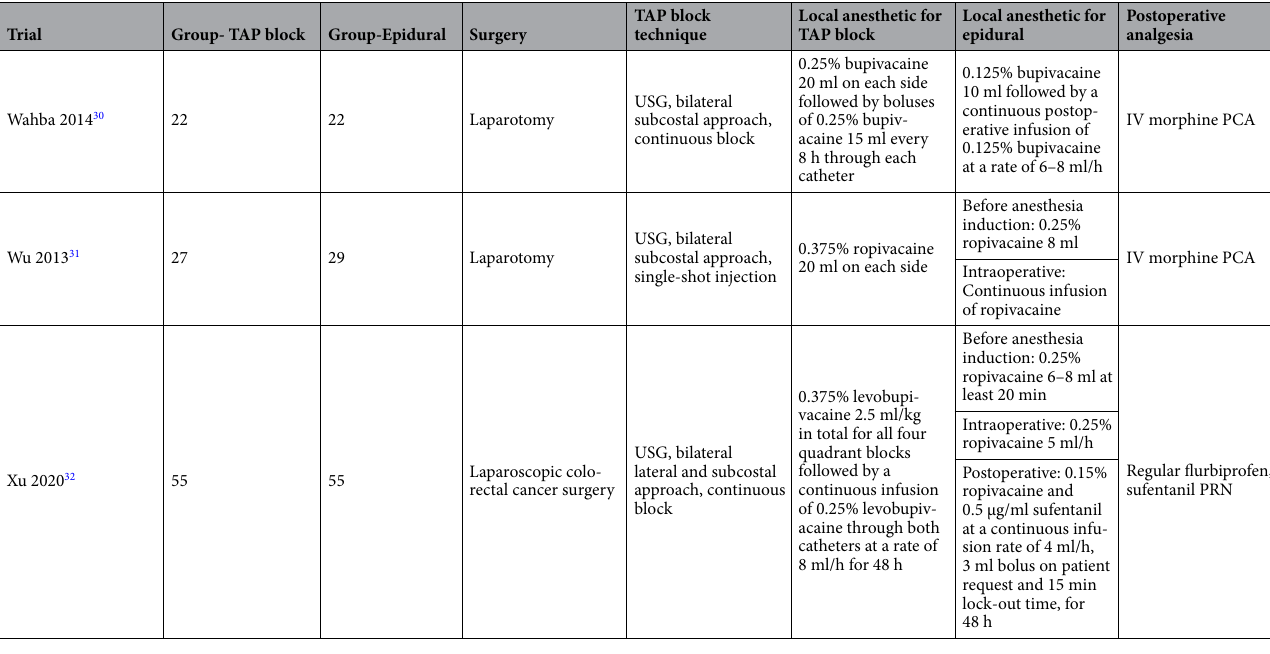
Table 1. Characteristic of the included